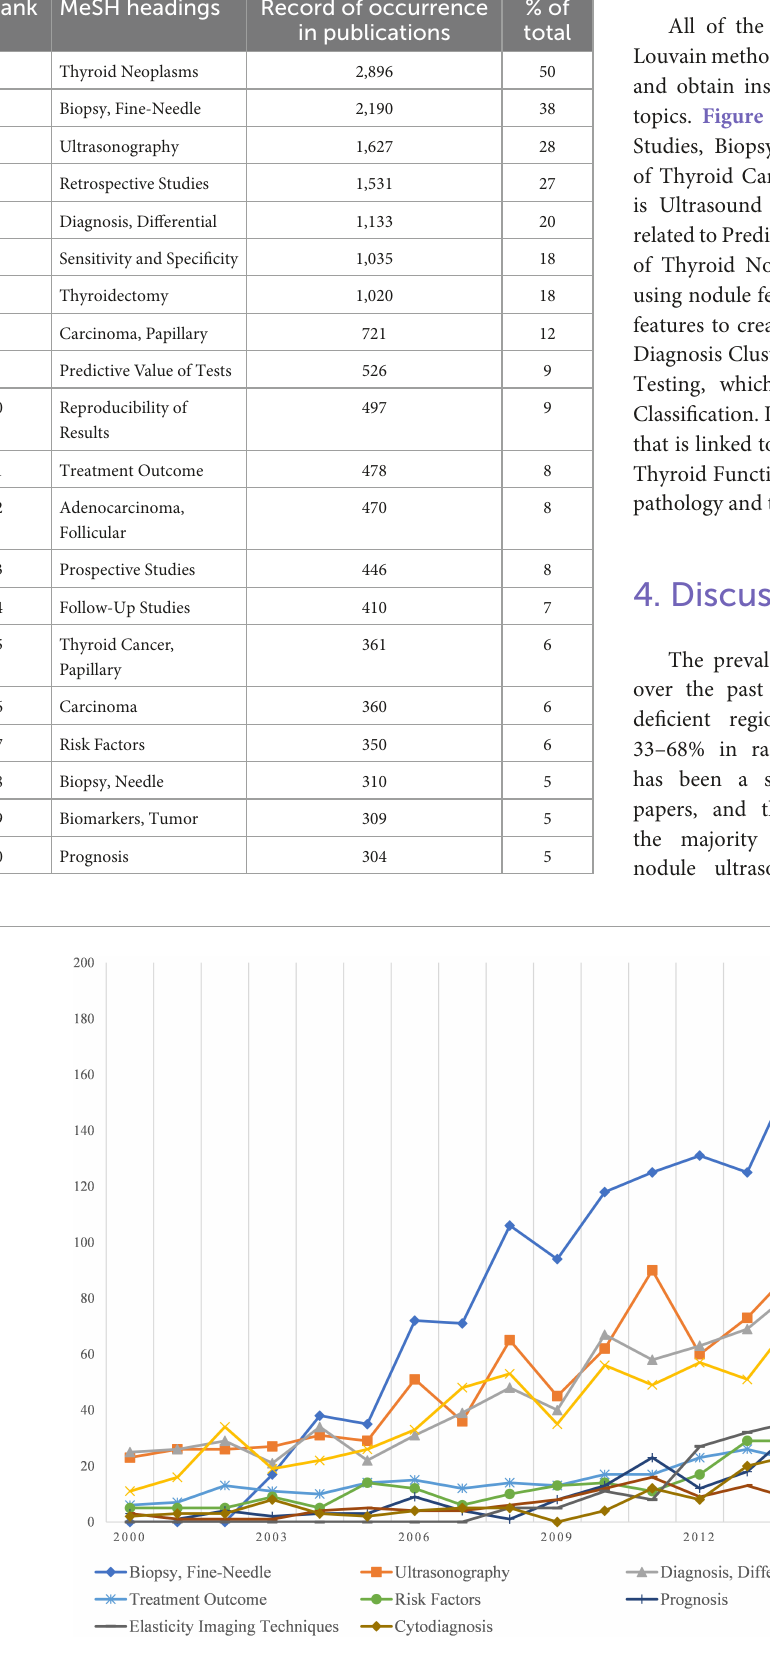
FIGURE3 Research foci trends related to clinical